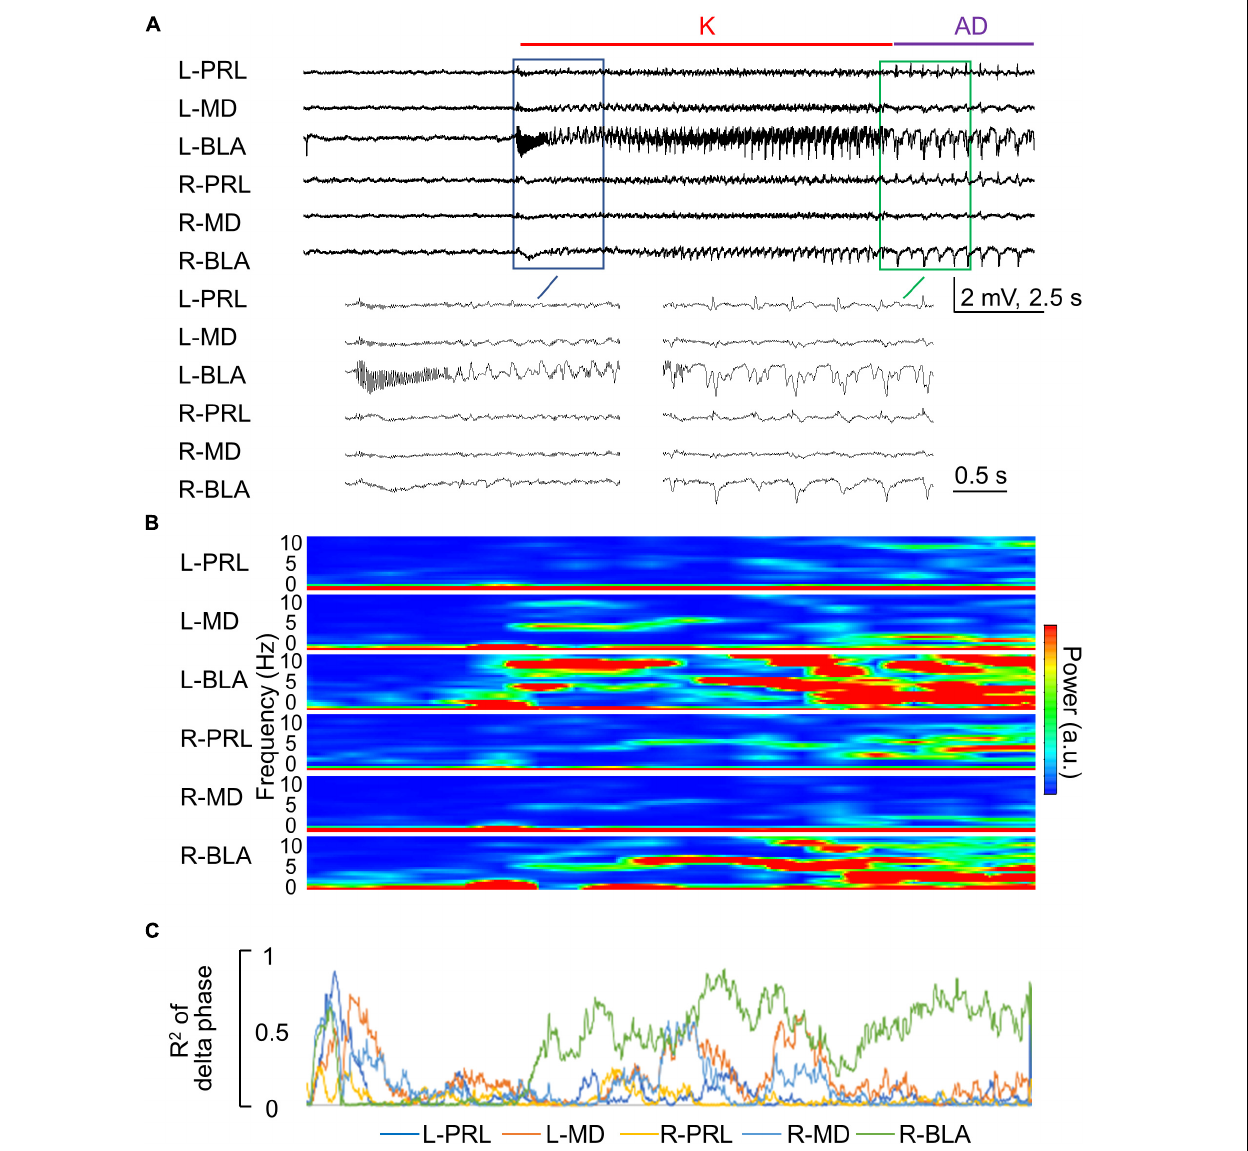
FIGURE 7 | Rapid propagation of epileptiform discharges to the other brain regions during the kindling stimulation. (A) Sample LFP recordings show that the epileptiform discharges gradually emerge in different recording sites in the first 1–2 s after initiation and cessation [i.e., AD] of the stimulation in the first session of kindling (enlarged). In this case, the kindling intensity is ± 70 µ A, and the rats expressed Racine stage 0.5 and 1 behavioral seizures at spike-wave discharge (SWD) and AD, respectively. (B) Spectrogram analysis of Part (A) shows that the major power of epileptiform discharges is the delta range (1–5 Hz). (C) Phase synchronization of delta waves in Part (A) between L-BLA and in the different structures shows that the right basolateral amygdala (R-BLA) has by far the strongest synchronization with L-BLA in the 10 s kindling stimulation and immediately afterward, i.e., during the AD. Note that Parts (B,C) are analyses based on the recordings in Part (A) and thus share the same time